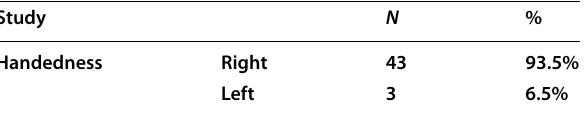
N.B. All the adult (control) group were right handedness